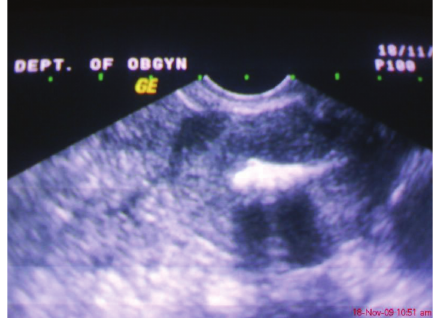
Figure 1: Transvaginal ultrasonography of the uterus revealed calcific areas.